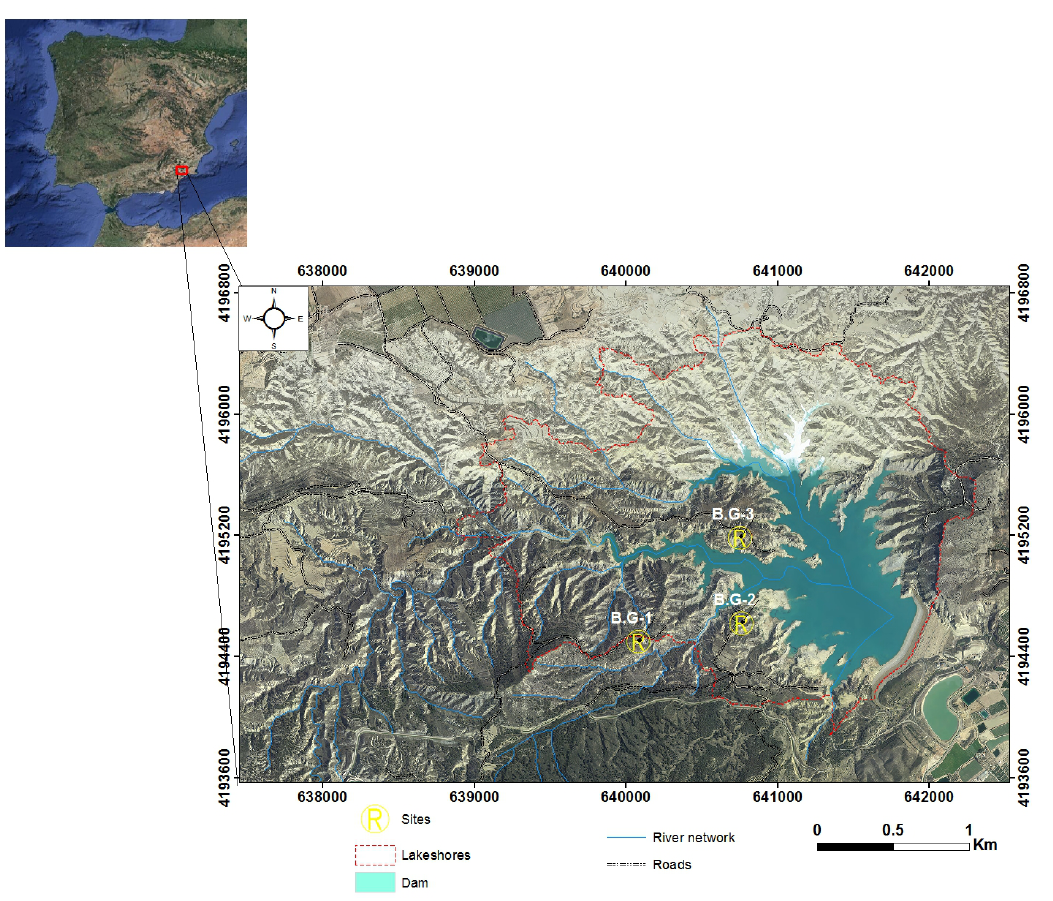
Figure 1. Location of the study